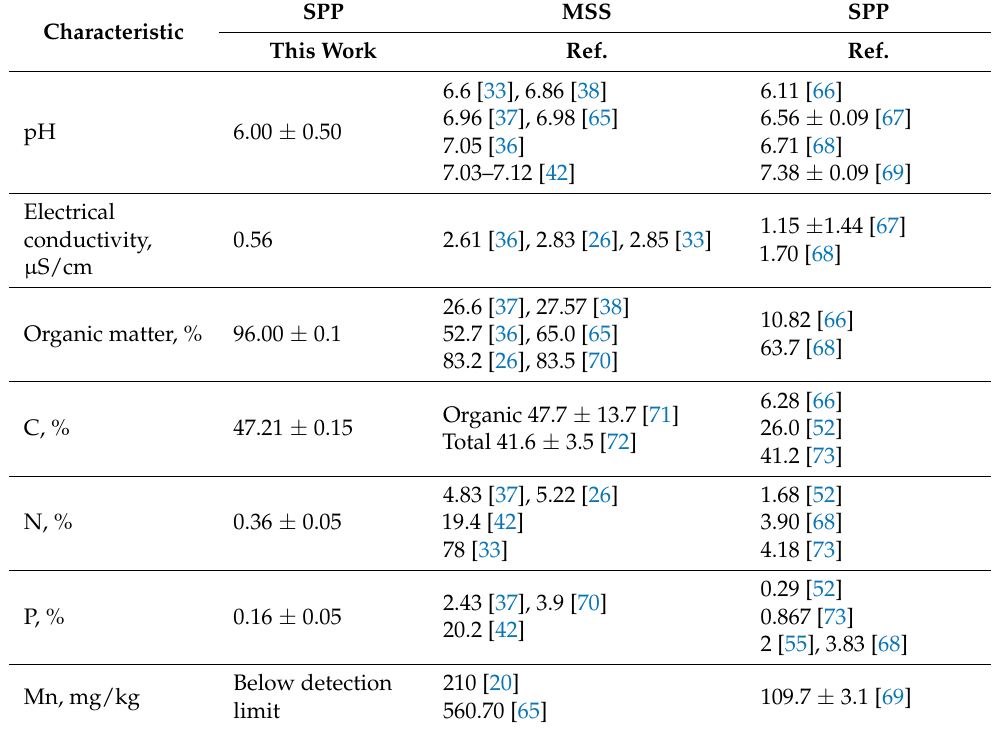
Table 1. Results of physical and biochemical properties of used SPP compared with average composi- tions of municipal sewage sludge (MSS) and sludge from pulp and paper industry (SPP).